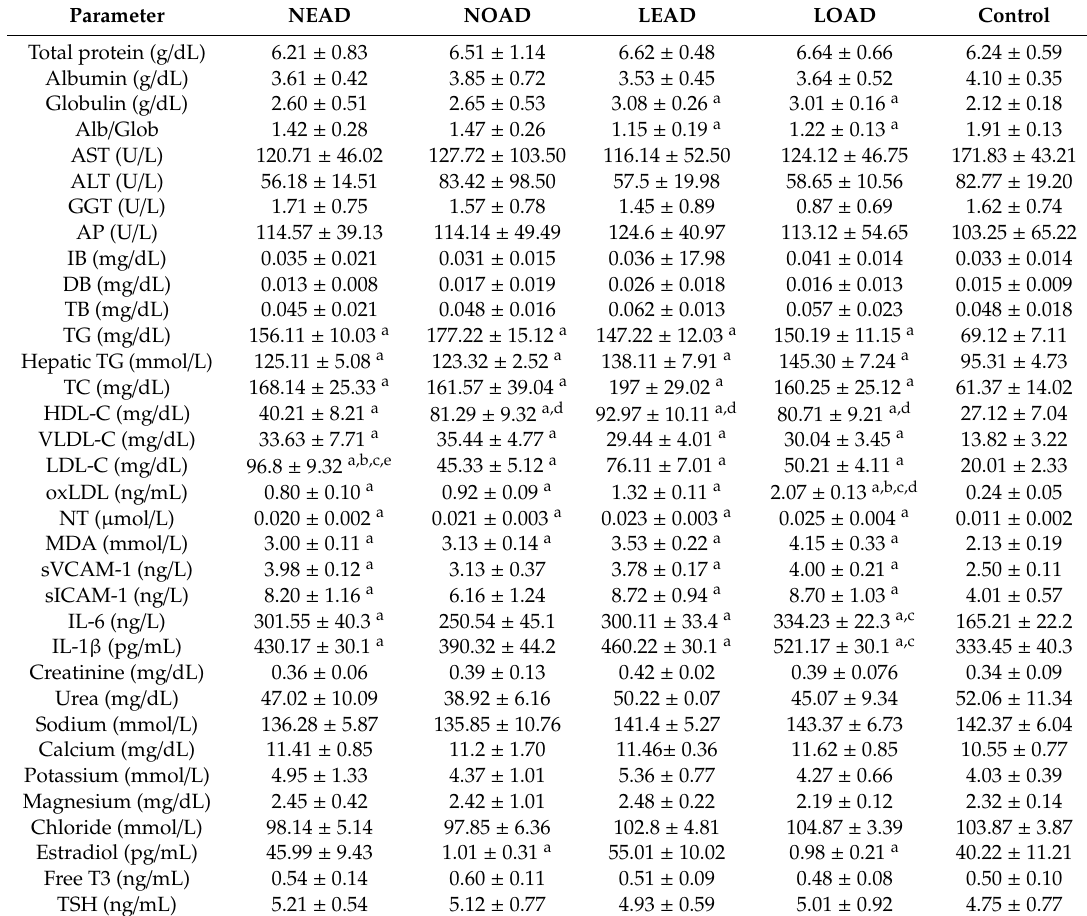
Table 4. Biochemical parameters in the various groups over 60 days of